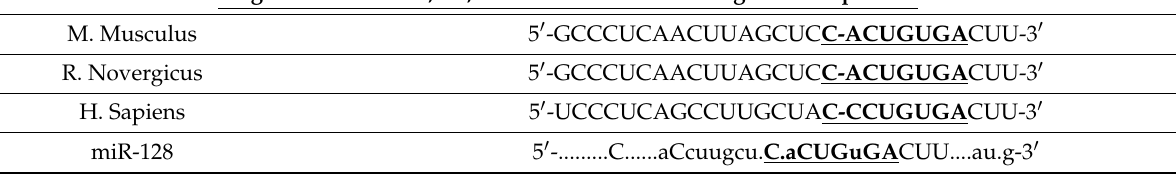
Binding of miR-128 to mouse Npr1 3 ′ UTR. Black vertical lines represent perfect matches of sequence homology between Npr1 3 ′ -UTR (top) and miR-128 (bottom). Bold underlined characters represent alignment of the seed sequence for miR-128 and recognition sequence of 3 ′ -UTR of Npr1 gene in mouse ( Mus musculus ), rat ( Rattus norvegicus ), and human ( Homo sapiens ). UTR, untranslated region; mmu, mouse.